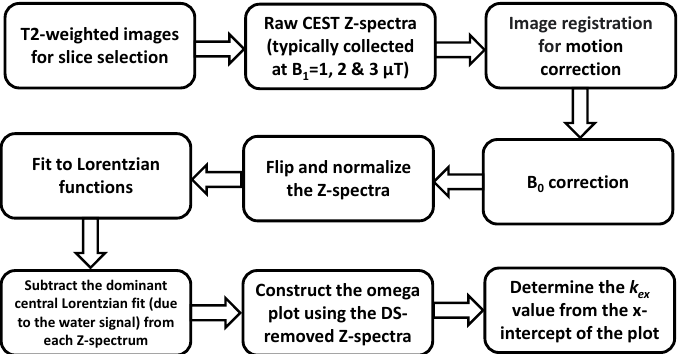
Figure 1. Flowchart of data processing steps in the DS-removed Omega plot method for quantifying in vivo tissue k ex .